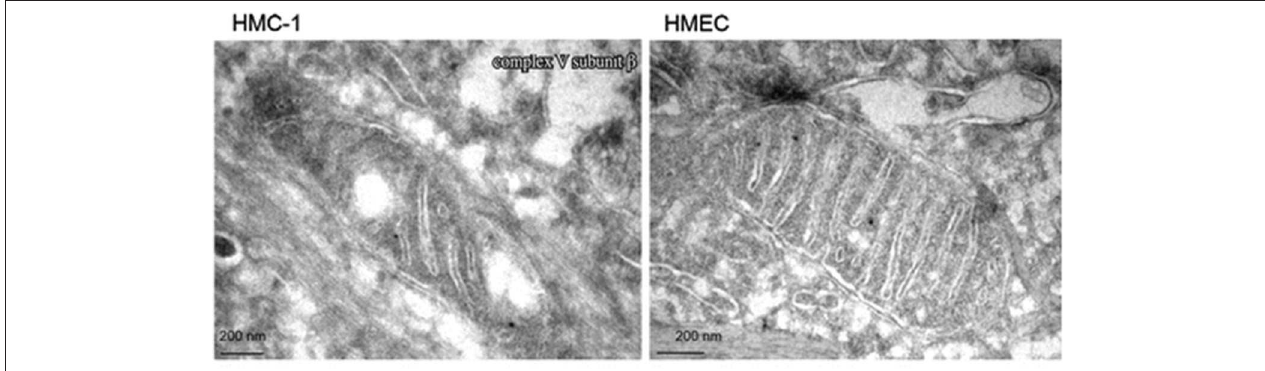
FIGURE 1 | Electron microscopy of primary breast cancer cells (human mammary carcinoma HMC-1) and human epithelial mammary cell control line (HEMC). Abnormal mitochondrial morphology in the HMC-1 cell showing loss of invaginations and vacuoles. These abnormalities in mitochondria ultrastructure were linked to abnormalities in the electron transport chain and are in general agreement with those from other studies of breast cancer mitochondria (37, 40, 42). Reprinted with permission from Putignani et al. (43).